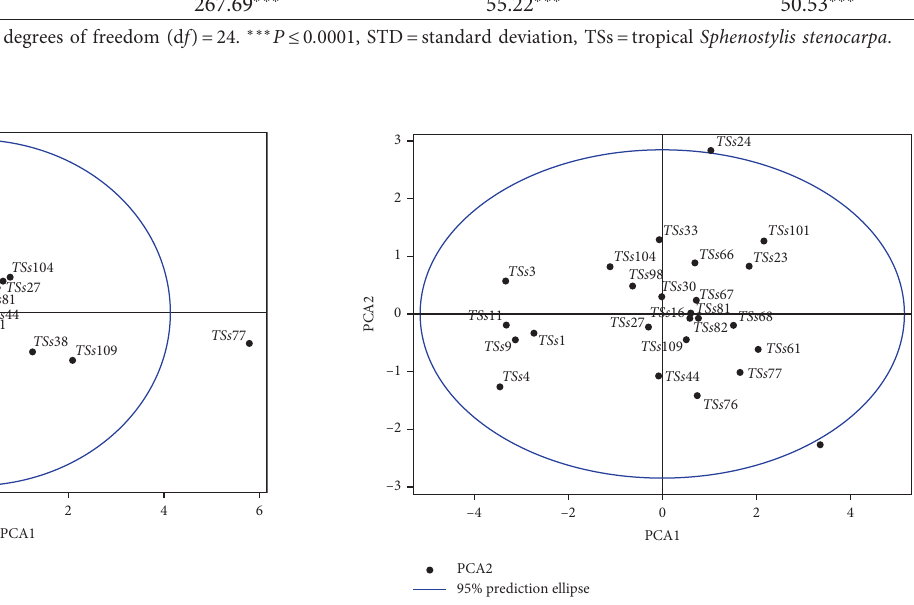
Figure 1: Multivariate analysis based on proximate contents of processed samples. PCA: principal component axis; TSs: Tropical Sphenostylis stenocarpa .